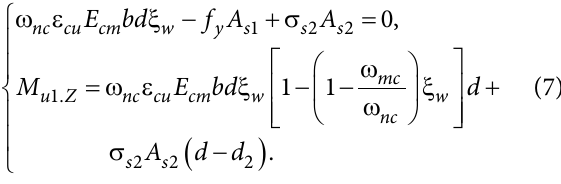
Fig. 2. The forces acting on flexed element cross-section (Židonis 2007a)